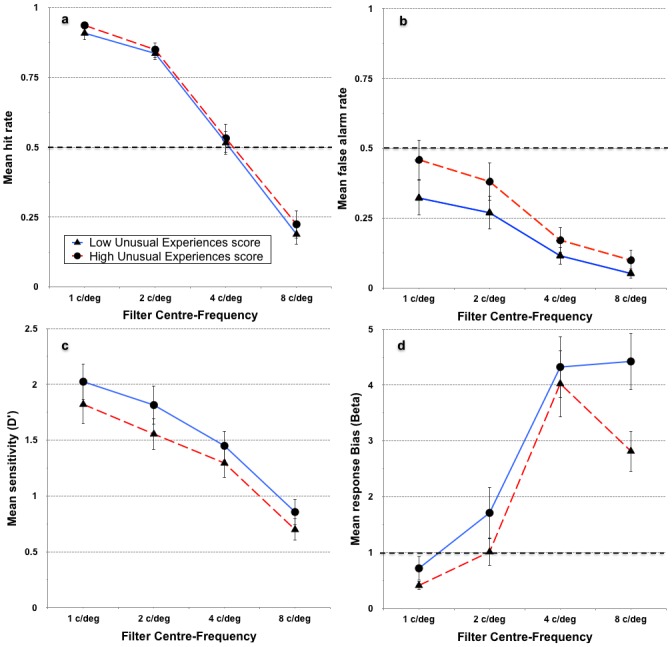
Performance across the different spatial frequency brackets, collapsed across expectation, of the Perception Of Meaning task.Data plotted separately for individuals scoring below and above the median on the UnEx subscale of the O-LIFE (N = 94, error bars represent ±95% confidence intervals). The reference lines in panels a and b represent chance performance (yes-no task), whereas the reference line at β = 1 in panel d represents the point of no response bias for an unbiased responder. A β value less than 1 indicates a bias toward saying a face was present in a noise-only stimulus.